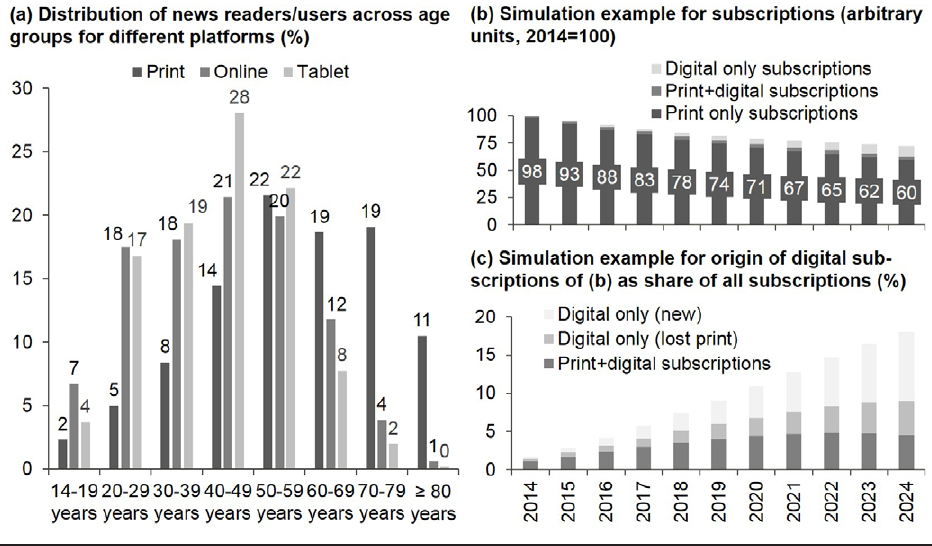
Figure 10: Comparison of news consumption on different platforms and model example for subscription schemes across platforms. Source : Own elaborations based on data from AWA (2014) and model